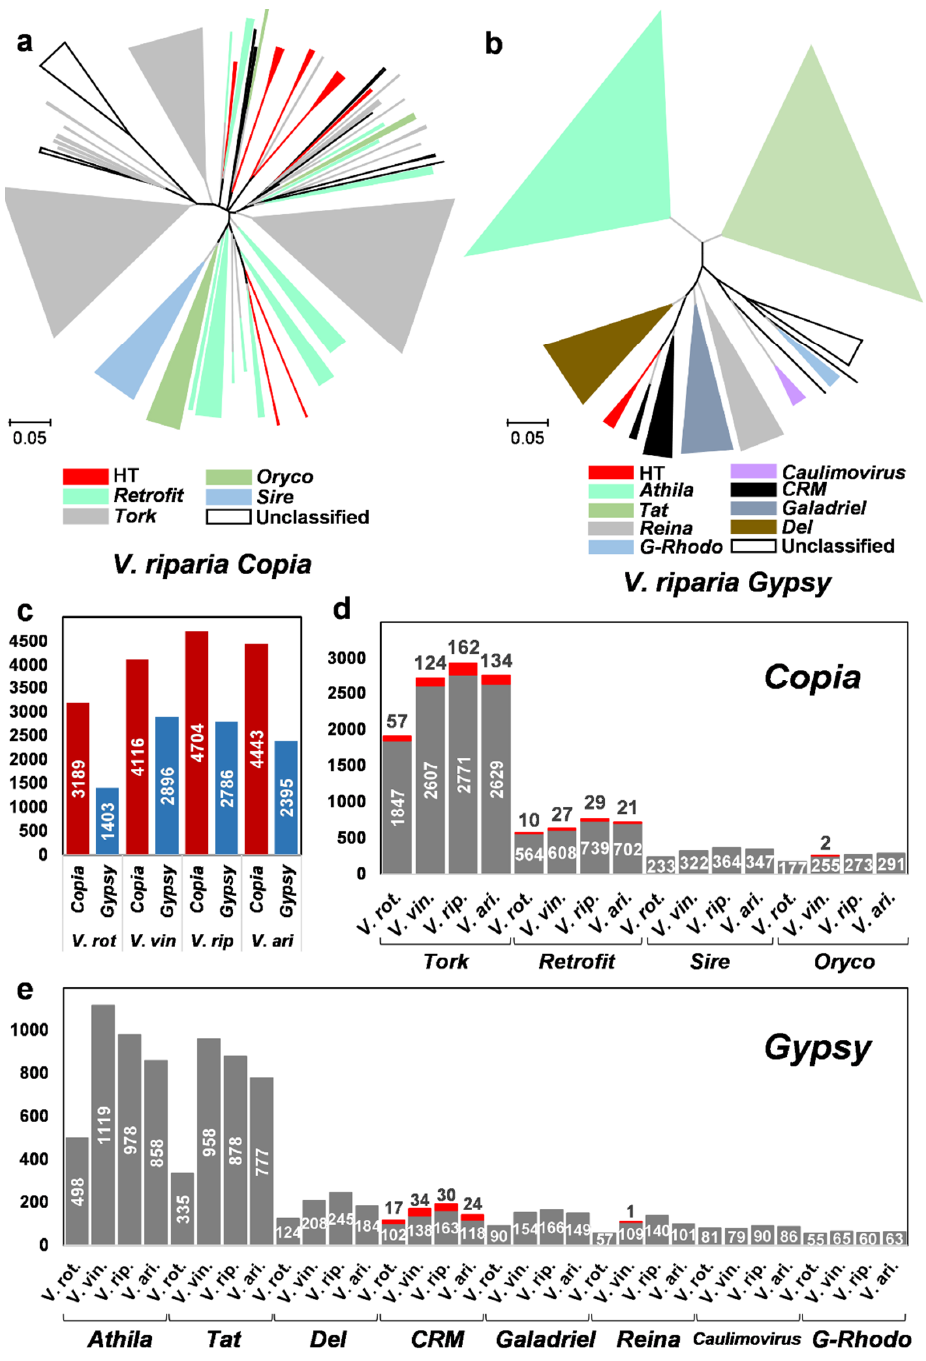
Figure 5. Composition of the horizontally transferred LTR retrotransposons in the four Vitis genomes. ( a , b ) Phylogenetic trees of Copia ( a ) and Gypsy ( b ) elements in V. riparia . The clusters are represented with colored triangles, and the classified families are presented in different colors. The unclassified clusters are presented with empty triangles. The clusters for the horizontally transferred LTR retrotransposons are marked with red triangles. ( c ) The numbers of RTs in the four Vitis genomes are compared. The sizes of the Copia and Gypsy superfamilies are shown by red and blue bars, respectively, and the values are shown in each of the bars. ( d , e ) The sizes of Copia ( d ) and Gypsy ( e ) families and the proportions of horizontally transferred elements in each family are compared. The number of LTR retrotransposons (excluding horizontally transferred elements) and the horizontally transferred elements are presented with gray and red bars, respectively, and the values are shown in the middle or at the top of the bars. The species name and the name of the LTR retrotransposon family are shown at the bottom of the panel. Abbreviations: V. rot. : Vitis rotundifolia , V. vin. : Vitis vinifera , V. rip. : Vitis riparia , and V. ari .: Vitis arizonica